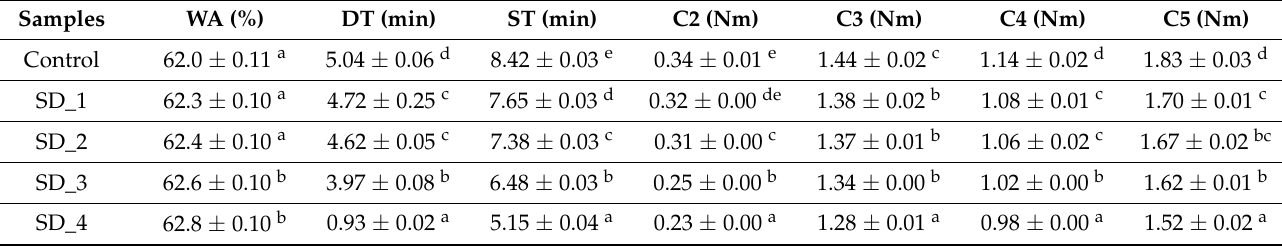
Table 1. Mixolab rheological properties of dough samples with different levels of dry sourdough (SD) addition.